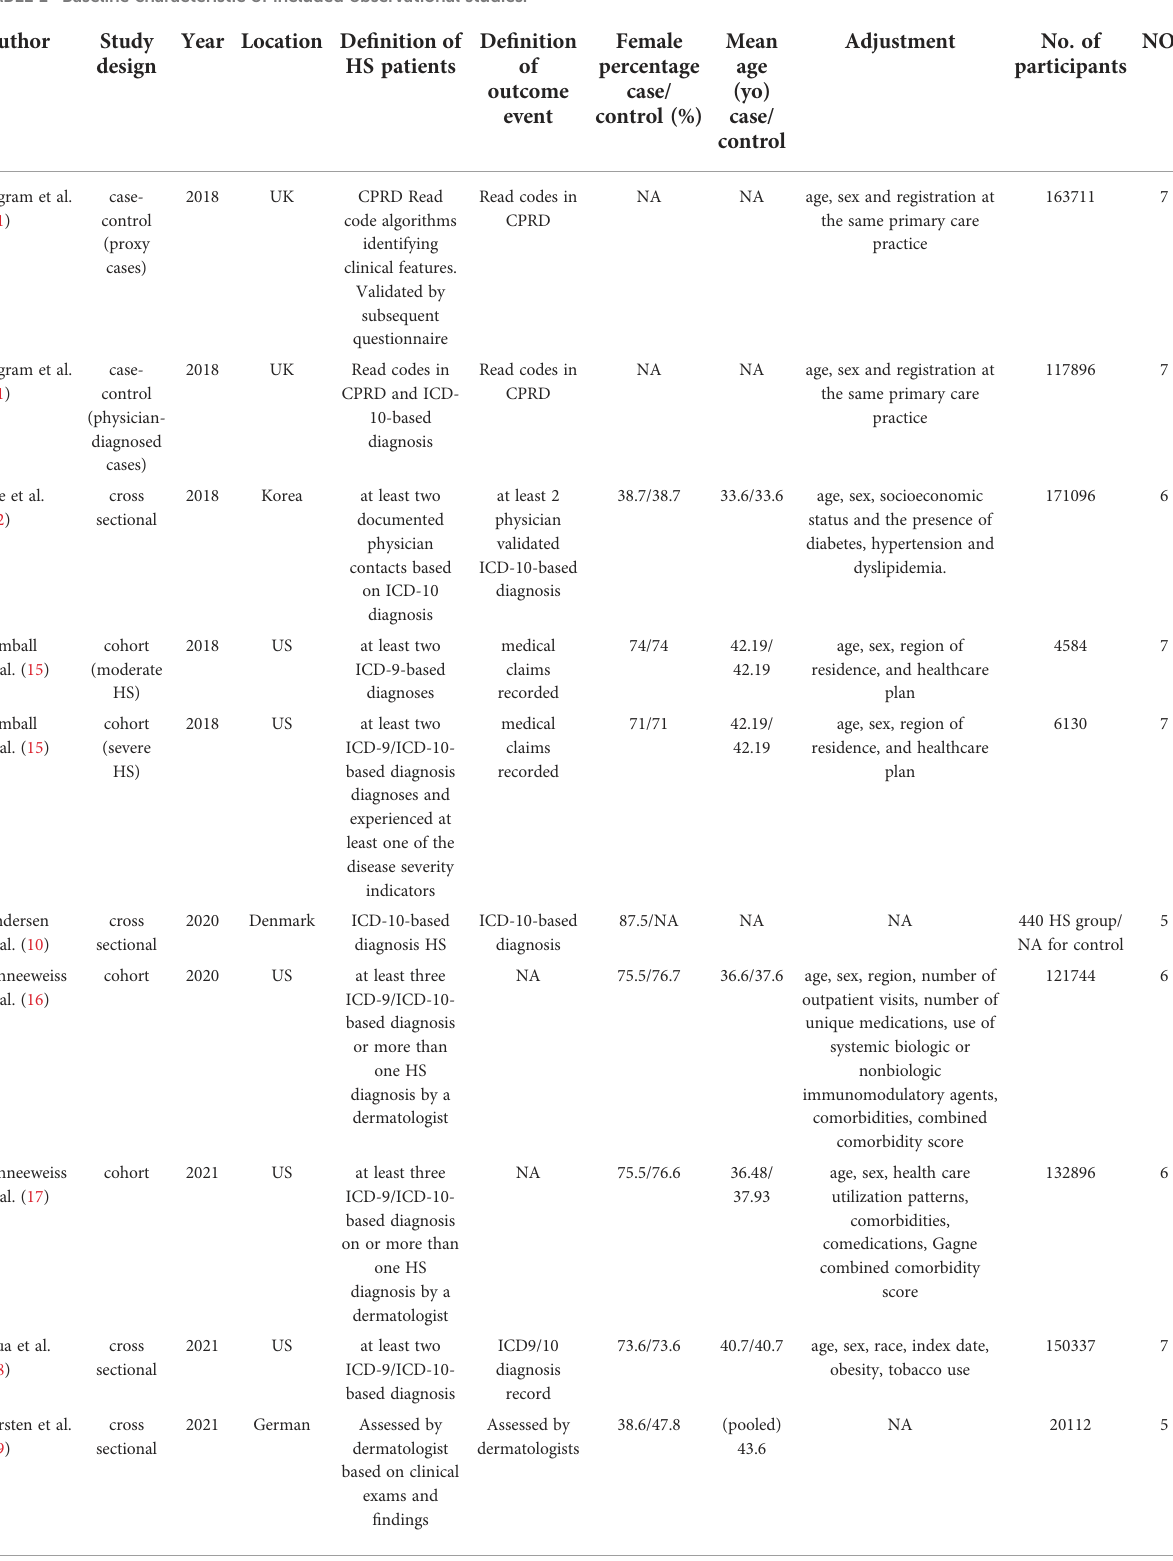
TABLE 1 Baseline characteristic of included observational